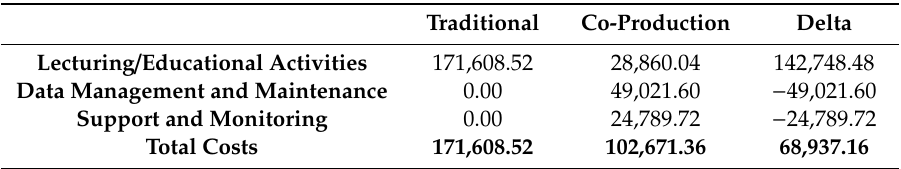
Table 6. Opportunity–cost analysis between di ff erential costs of the co-production approach followed in beFood and the traditional